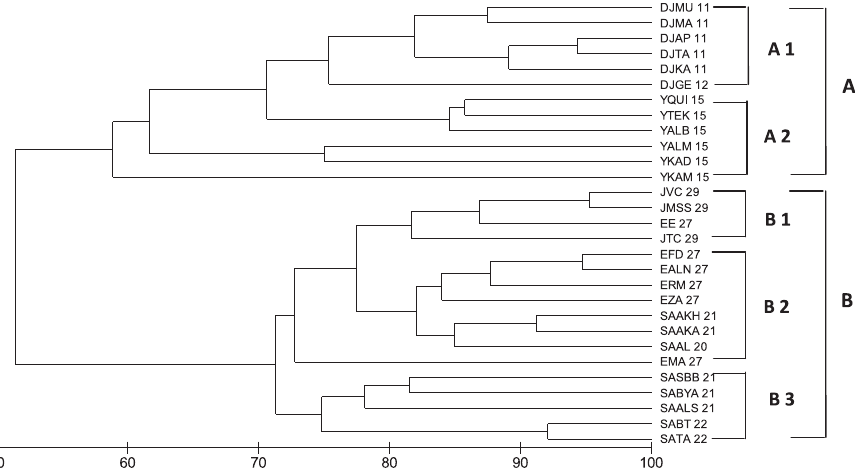
Figure 7. Cluster analysis of relationships between ornamental fish assemblages (Bray-Curtis similarity) from different countries in the Red Sea and Gulf of Aden region. Country Key: J29°= sites at latitude at 29° on the Jordanian coast, JMSS 29= Marine Science Station, JTC 29= Tourist Camp, JVC= Visitor Center; E27°= sites at latitude 27° in Egypt, EALN 27= AL-Noksh, EMA 27= Mahmoudat, EFD 27= Fanar Dolphin, EE 27= Elli, ERM 27= Ras Mohamad, EZA 27= Zorab; SA22, SA21 and SA20° = sites at latitudes on the Saudi Arabia coast, SATA 22= Thoal- Awjam, SABT 22= Bostek/Thoal, SAAKA 21= Alkabeera, SABYA 21= Bayada, SASBB 21= South Batch Bayada, SAALS 21= Al-Sagheera, SAAKH 21= Al-Kherq, SAAL 20= Alleeth; Y15°= sites at latitude along the Yemeni coast, YKAD 15= Kadaman, YKAM 15= Kamaran, YTEK 15= Tekfash, YQUI 15= Quish, YALM 15= Al-murk, YALB 15= Al-Badi; Dj11 and Dj12° =sites at latitudes 11 and 12° along the Djiboutian coast, DJGE 12= Gehere, DJKA 11= Khor Ambado, DJMA 11= Maskali, DJMU 11= Musha, DJTA 11= Tajoura, DJAP 11=